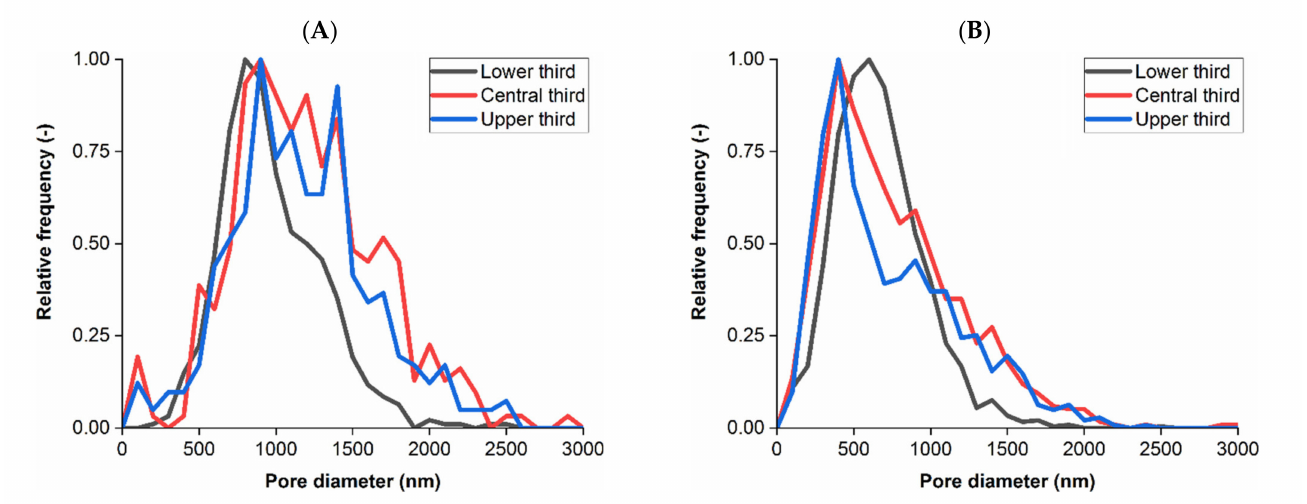
Figure 4. Membrane pore size distribution. ( A ) Upstream membrane subvolume, 650 nm nominal retention rating. Average pore size for each third: upper 1115 nm, central 1149 nm, lower 938 nm. ( B ) Downstream membrane subvolume, 200 nm nominal retention rating. Average pore size for each third: upper 616 nm, central 711 nm, lower 686 nm. Subvolumes were split into thirds for positional based